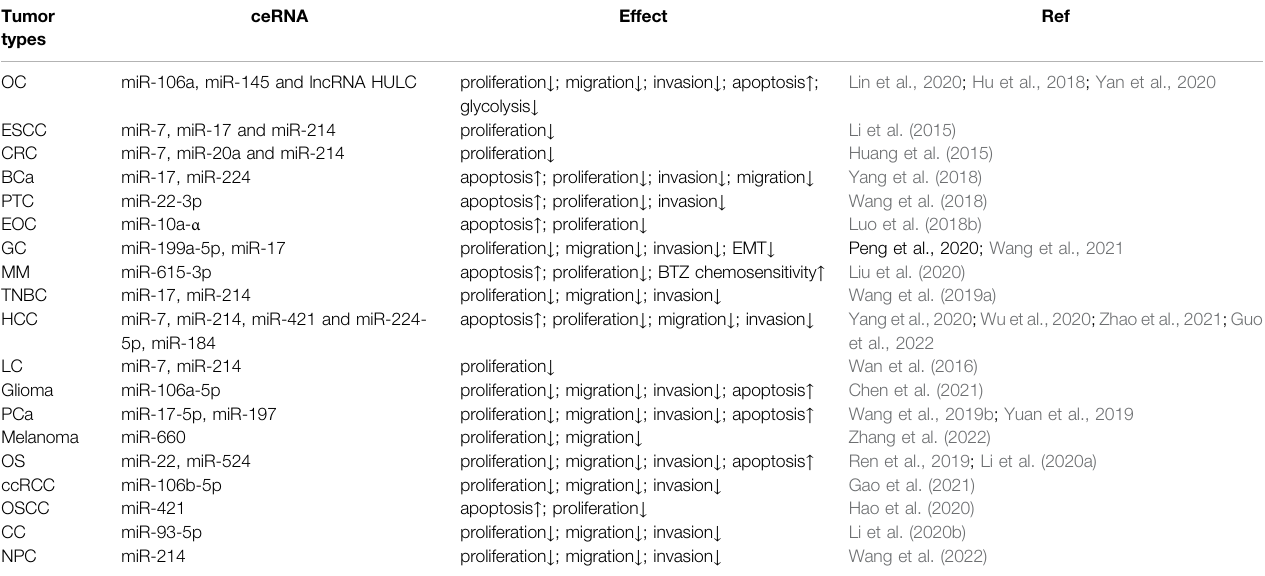
TABLE 1 | Anti-tumor mechanism of circ-ITCH in a variety of malignant tumors. Tumor